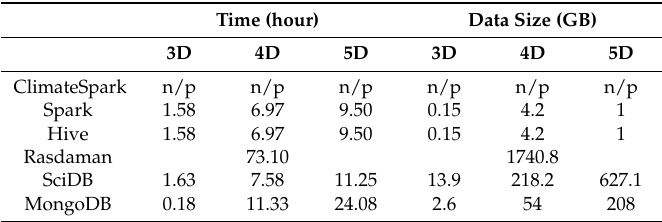
Table 6. Data Preprocessing Time and Intermediate Data